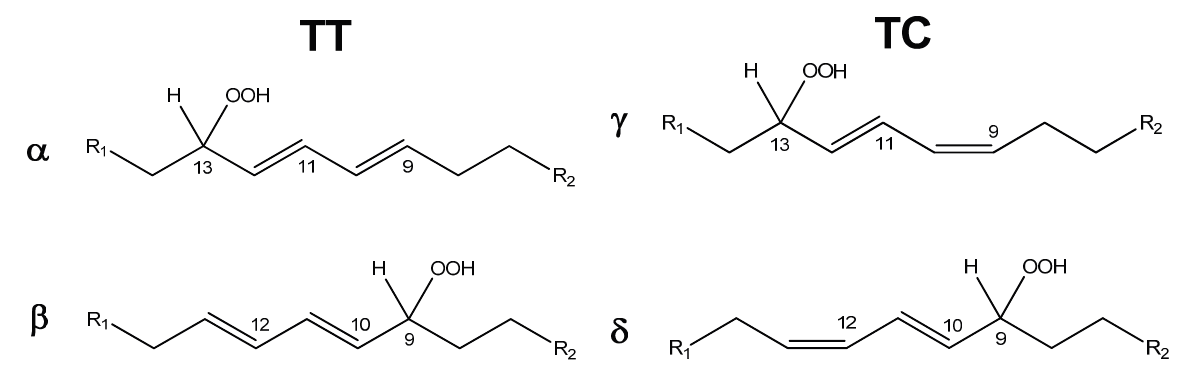
Figure 2. Different hydroperoxides formed during the aerobic oxidation of methyl linoleate catalyzed by CD-NHPI derivatives. α : Methyl 13-( R , S )-hydroperoxy-9- trans , 11- trans -octadecadienoate; β : Methyl 9-( R , S )-hydroperoxy-10- trans ,12- trans -octadecadienoate; γ : Methyl 13-( R , S )-hydroperoxy-9- cis ,11- trans -octadecadienoate; δ : Methyl 9-( R , S )- hydroperoxy-10- trans ,12- cis- octadecadienoate. R 1 = CH 3 (CH 2 ) 3 ; R 2 = (CH 2 ) 5 CO 2 CH 3